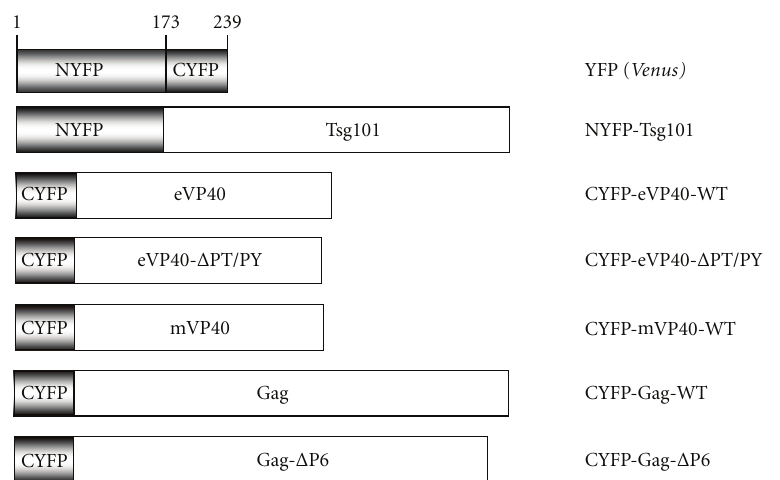
Figure 1: Schematic diagram of EYFP fusion proteins. The N-terminal half of EYFP (aa 1–173) was joined in-frame to full-length Tsg101, and the C-terminal half of EYFP (aa 174–239) was joined in-frame to the indicated WT or L-domain mutant VP40 or HIV-1 Gag proteins. A FLAG epitope tag is positioned at the N-terminus of mVP40-WT, and between the CYFP fragment and mVP40 in construct CYFP-mVP40- WT. The CYFP-Gag- Δ P6 construct was made by fusing the CYFP fragment in-frame with Gag L-domain deletion mutant (the entire p6 region containing L-domain motif PTAP is